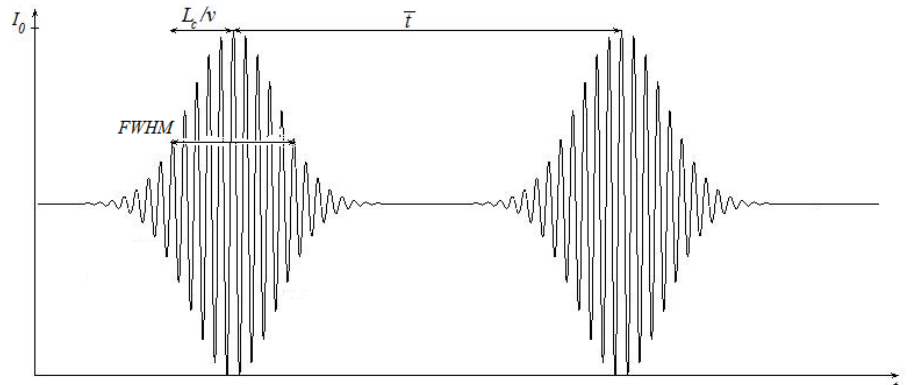
Figure 2. Photodetector interference figures in a Michelson interferometer with a low-coherence source when measuring a plastic film.